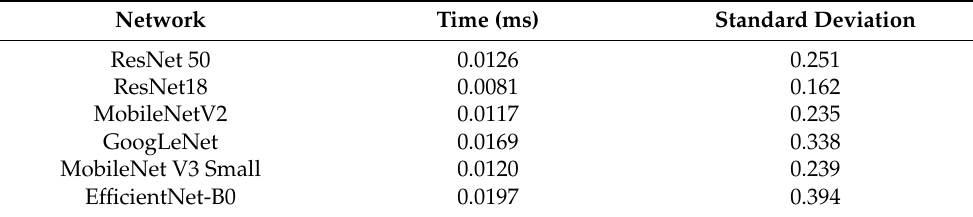
Table 6. Inference time by network architecture.